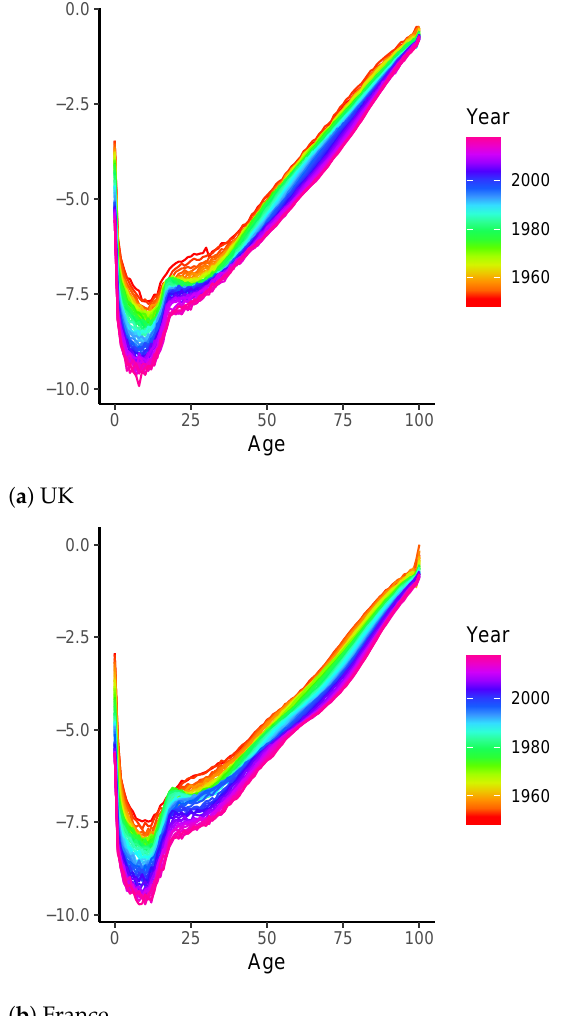
Figure 2. Uni-sex mortality data of the UK and France of age 0–100 and year